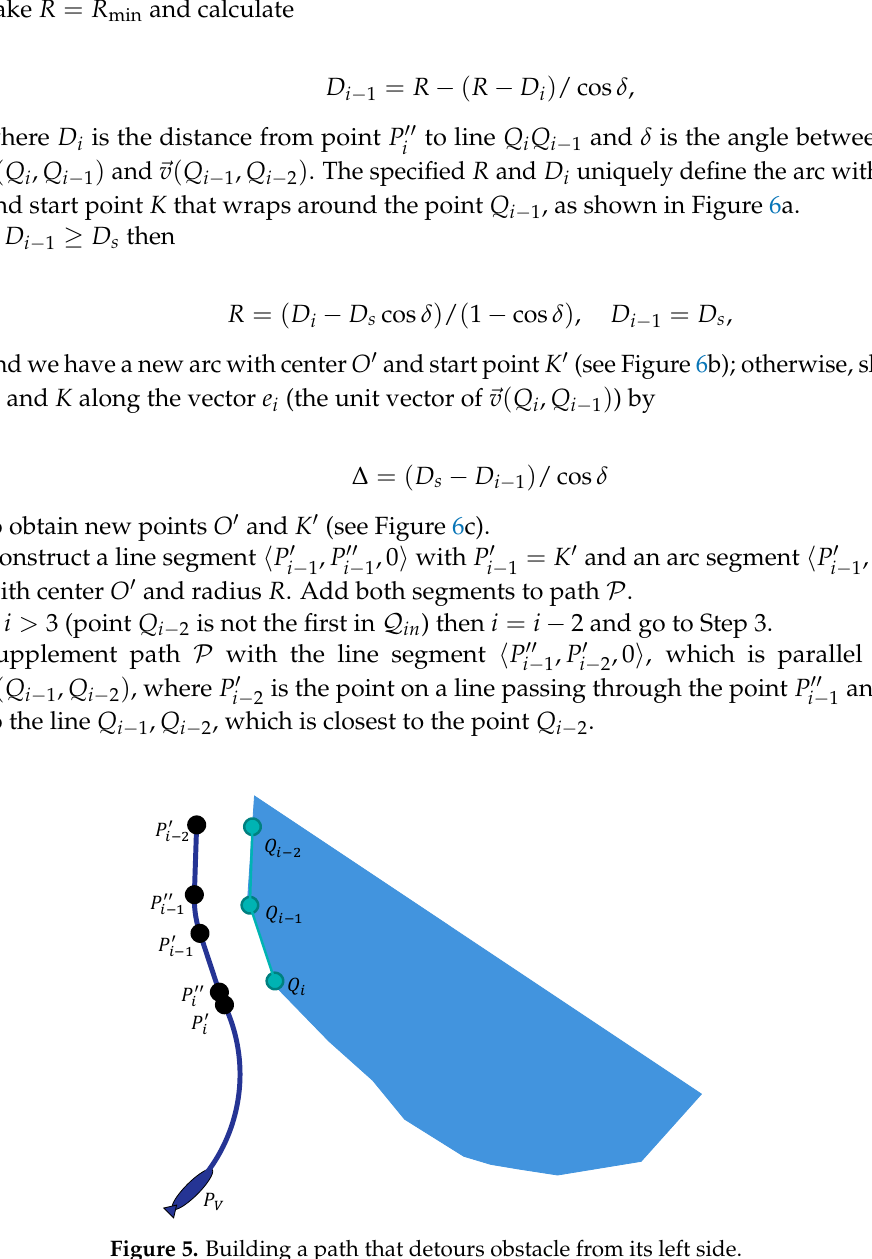
Figure 5. Building a path that detours obstacle from its left